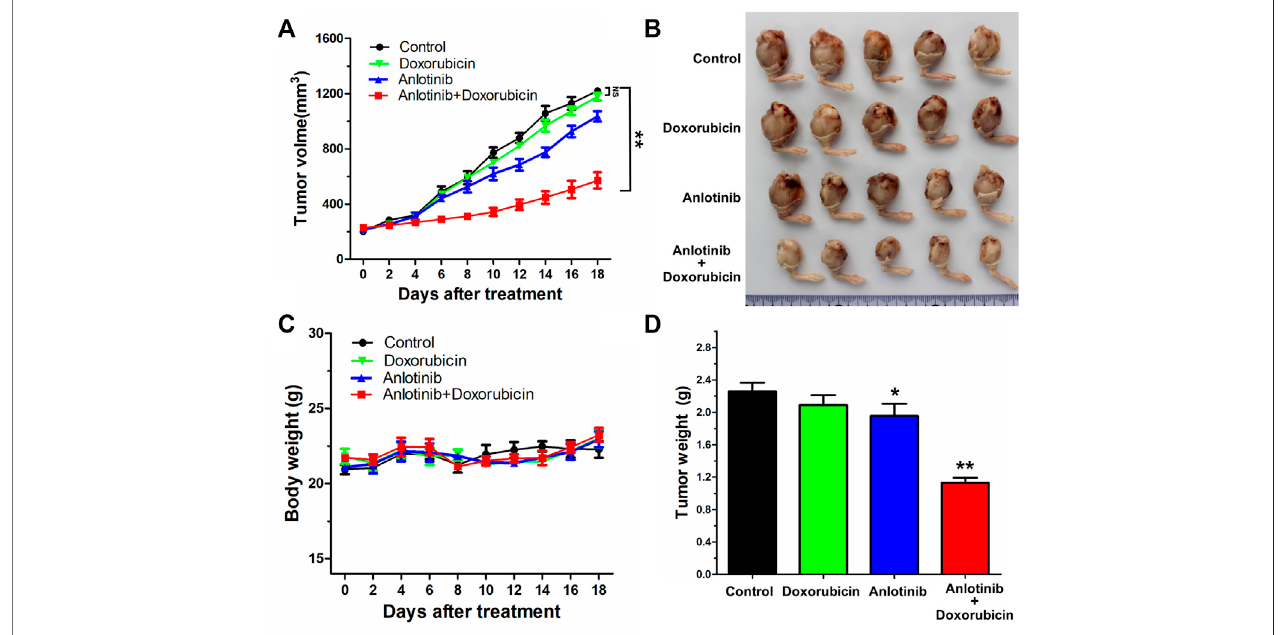
FIGURE6| PotentiationoftheantitumoreffectsofDOXbyanlotinibinaKHOSR2xenograftmodelinathymicnudemice. (A) .Changesintumorvolumeovertimein the KHOSR2 xenograft model are shown (n (cid:1) 5). The data shown are the mean ± SD of the tumor volumes for each group. (B) . A representative image of the sizes of KHOSR2 tumors excised from different mice on the 18th day after implantation is shown. (C) . The body weights of the mice were measured every 2 days, and the averagepercentchangeaftertreatmentwascalculated. (D) .Meantumorweightsforthegroupsaftertumorexcisiononthe18thdayafterimplantation.Theresults are presented as the mean ± SD. * p < 0.05; ** p <